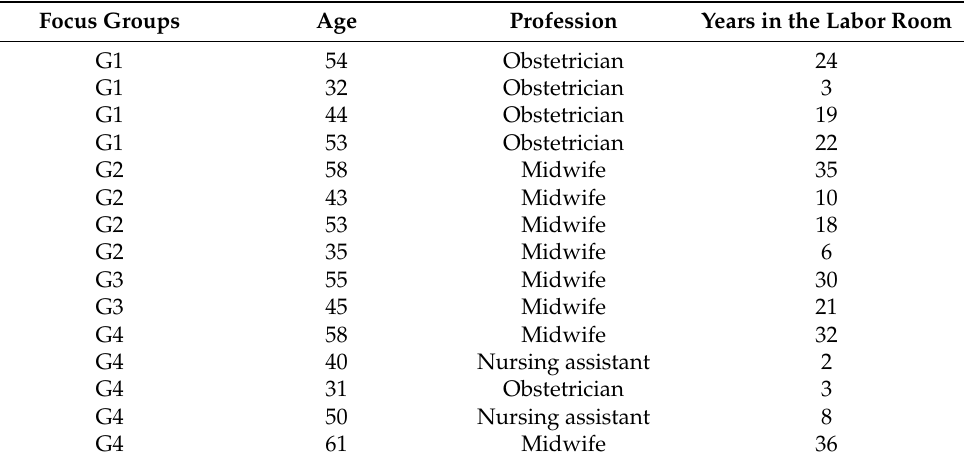
Table 2. Characteristics of the sample of professionals in the focus